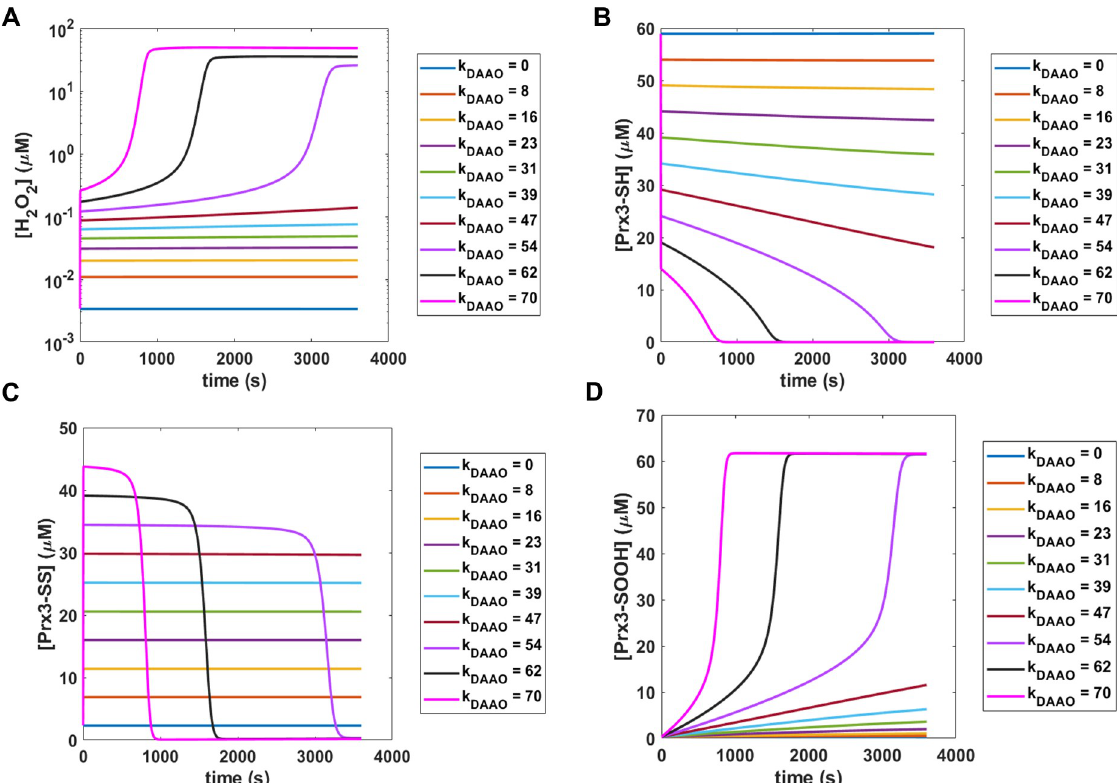
Fig 4. Perturbation analysis. Plots showing the dynamics of A) [H 2 O 2 ], B) [Prx3-SH], C) [Prx3-SS], and D) [Prx3-SOOH] with an initial Prx3-SH concentration of 62 μ M for increasing values of k DAAO . All values of k DAAO in μ M/s.